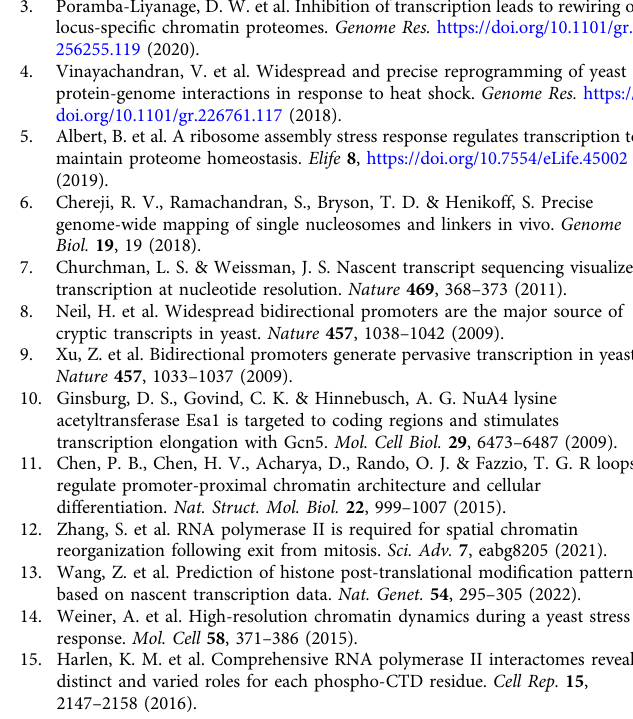
phosphorylation ChIP-seq 5 , FASTQ fi les were downloaded from the SRA (SRR8450263 and SRR8450261) and mapped using BWA. Fragment centers, estimated using an assumed fragment length of 150bp, were counted from the TSS to + 400 bp. These were depth normalized to compare to RNAPII normalized as described in Martin et al. Principal component analysis (PCA) was performed on all 5542 genes (TSS + 400) using the regularized log transformation and plotPCA functions of DEseq2 2 .